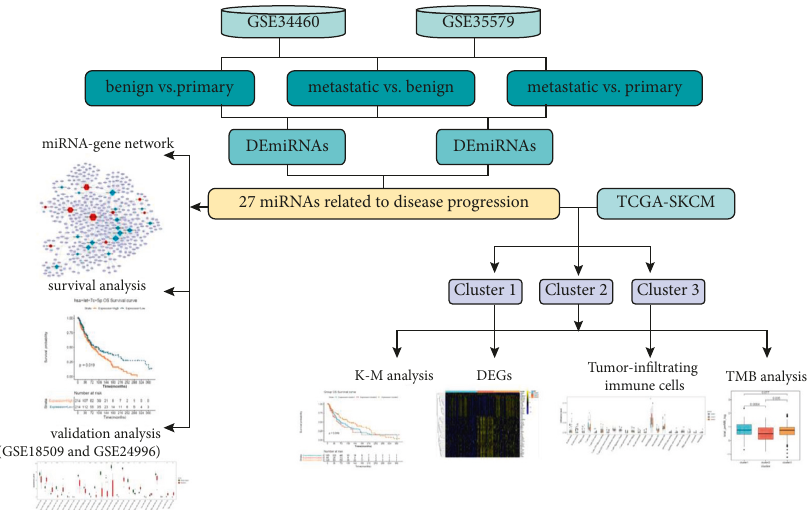
Figure 1: The flowchart of this